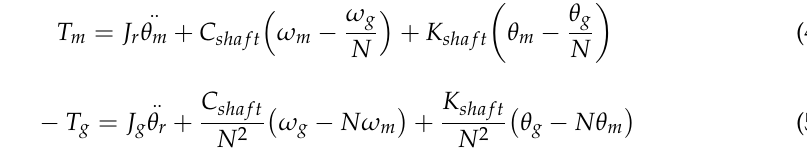
Figure 2. Drivetrain based on the two-mass shaft model.